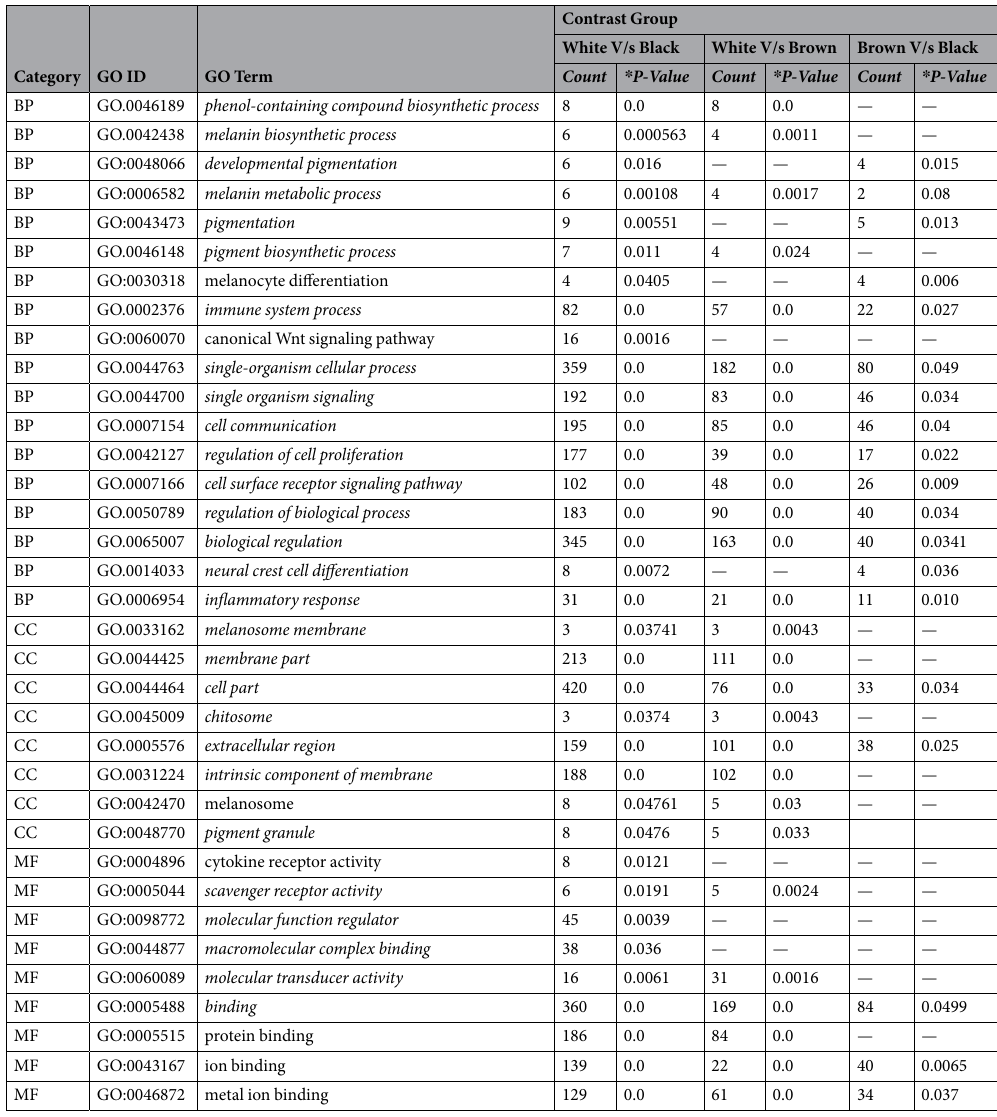
Table 1. Gene Ontology (GO) terms for differentially expressed genes. Note: ‘BP’, ‘CC’ and ‘MF’ represent biological process, cellular component and molecular function, respectively. * P-Value is FDR corrected